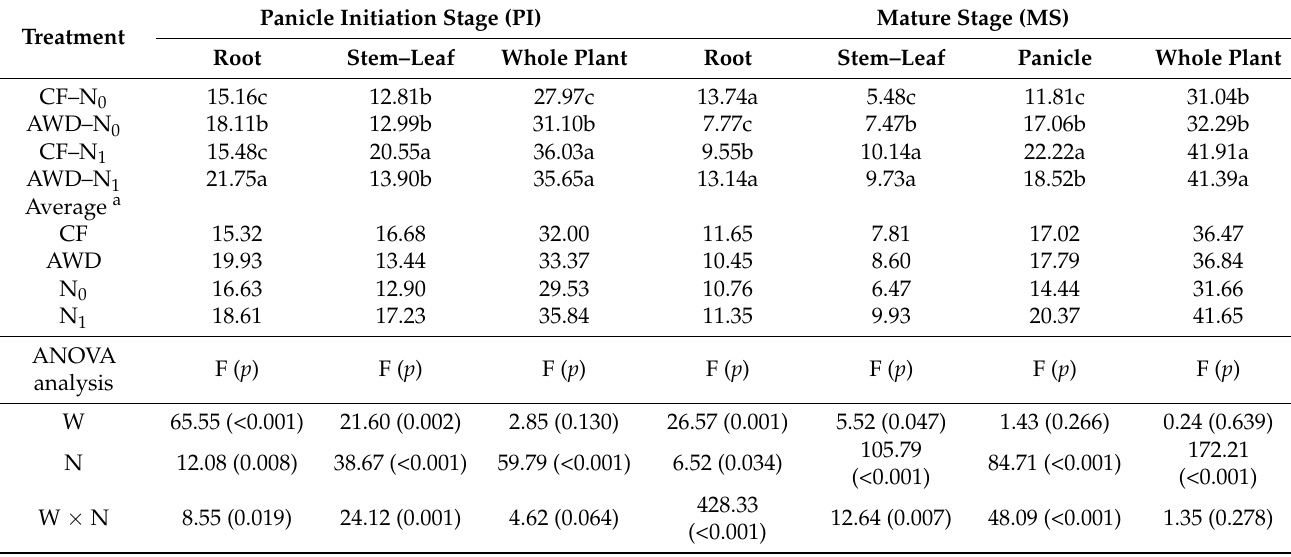
Table 2. Straw-N accumulation in various plant parts under different treatments (mg pot − 1 ).